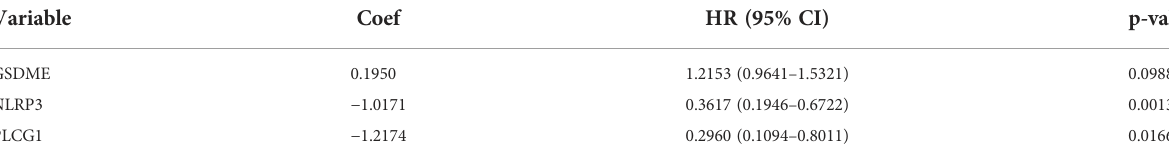
TABLE 2 Multivariate Cox regression analysis of signature in the 151-CLL-sample cohort.